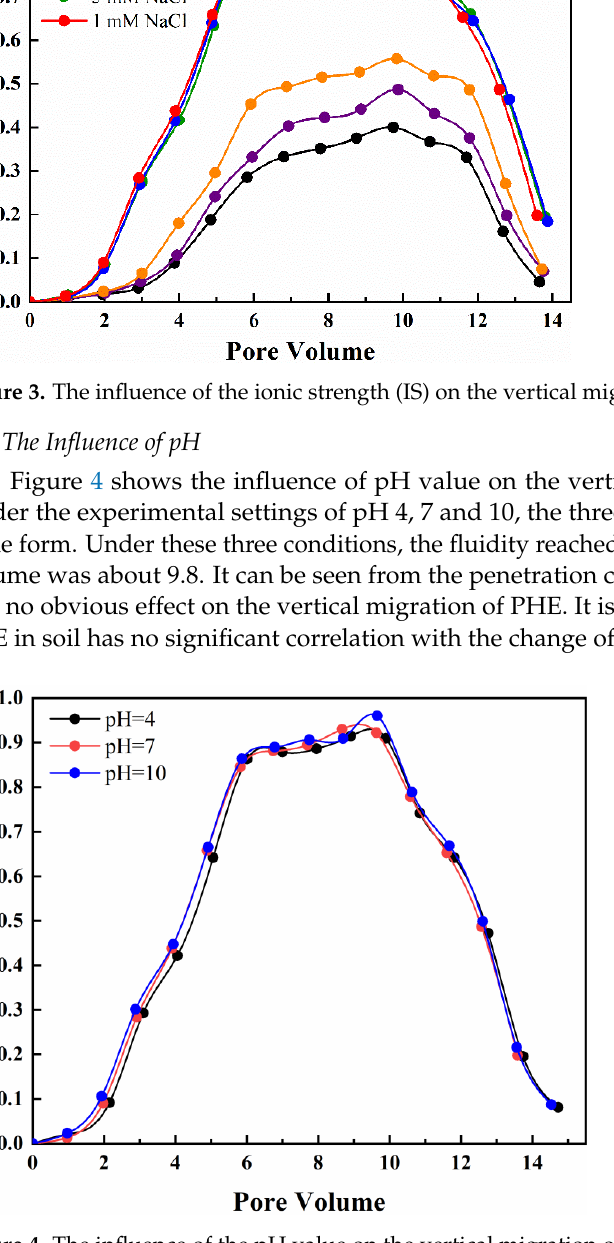
The penetration curves of PHE in soils with different particle sizes are shown in Figure 5. Within the pore volume range of 1~15, there was a peak in the penetration curves of the three particle sizes, which indicated that PHE can completely (0.45~1 mm) or partially (0~0.15 mm and 0.15~0.45 mm) pass through the leaching process of soil column. Additionally, the penetration curve with a particle size of 0.45~1 mm appeared to have a stable peak value of 1.00. Figure 5. The influence of the particle size on the vertical migration of PHE in soil.